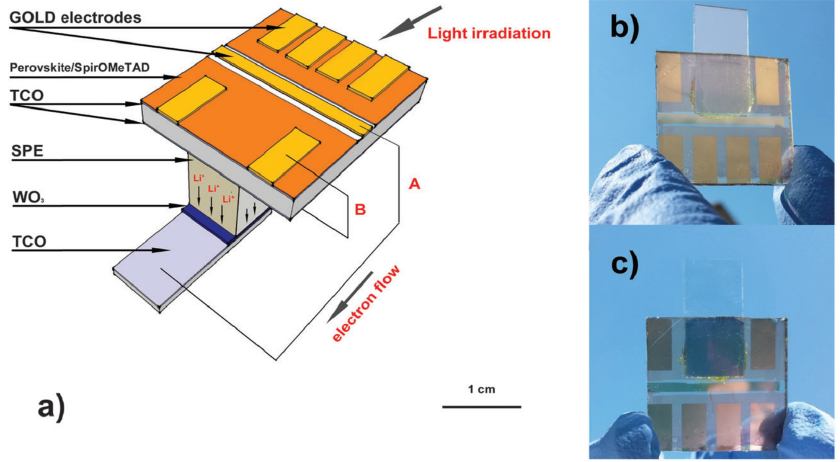
Figure 9. Axonometric view of a perovskite-based photovoltachromic device. Transparent conductive oxides (TCO), solid-state polymer electrolyte (SPE) ( a ). Pictures of the device in bleached ( b ) and colored ( c ) states. Reproduced by permission of The Royal Society of Chemistry [208].